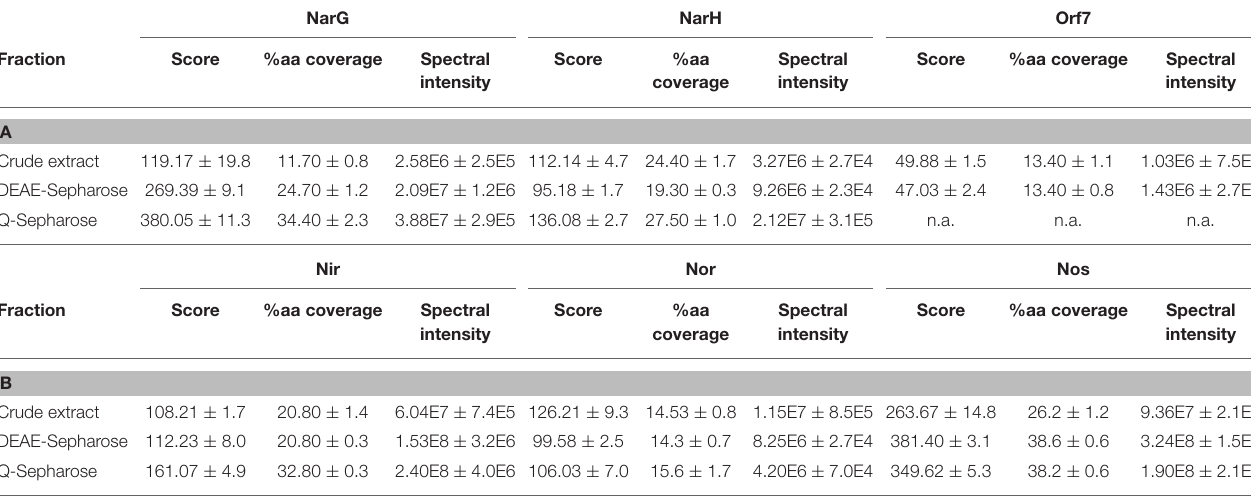
TABLE 2 | Score, protein sequence coverage, and spectral intensity values of the N-reductases during the enrichment process. NarG NarH